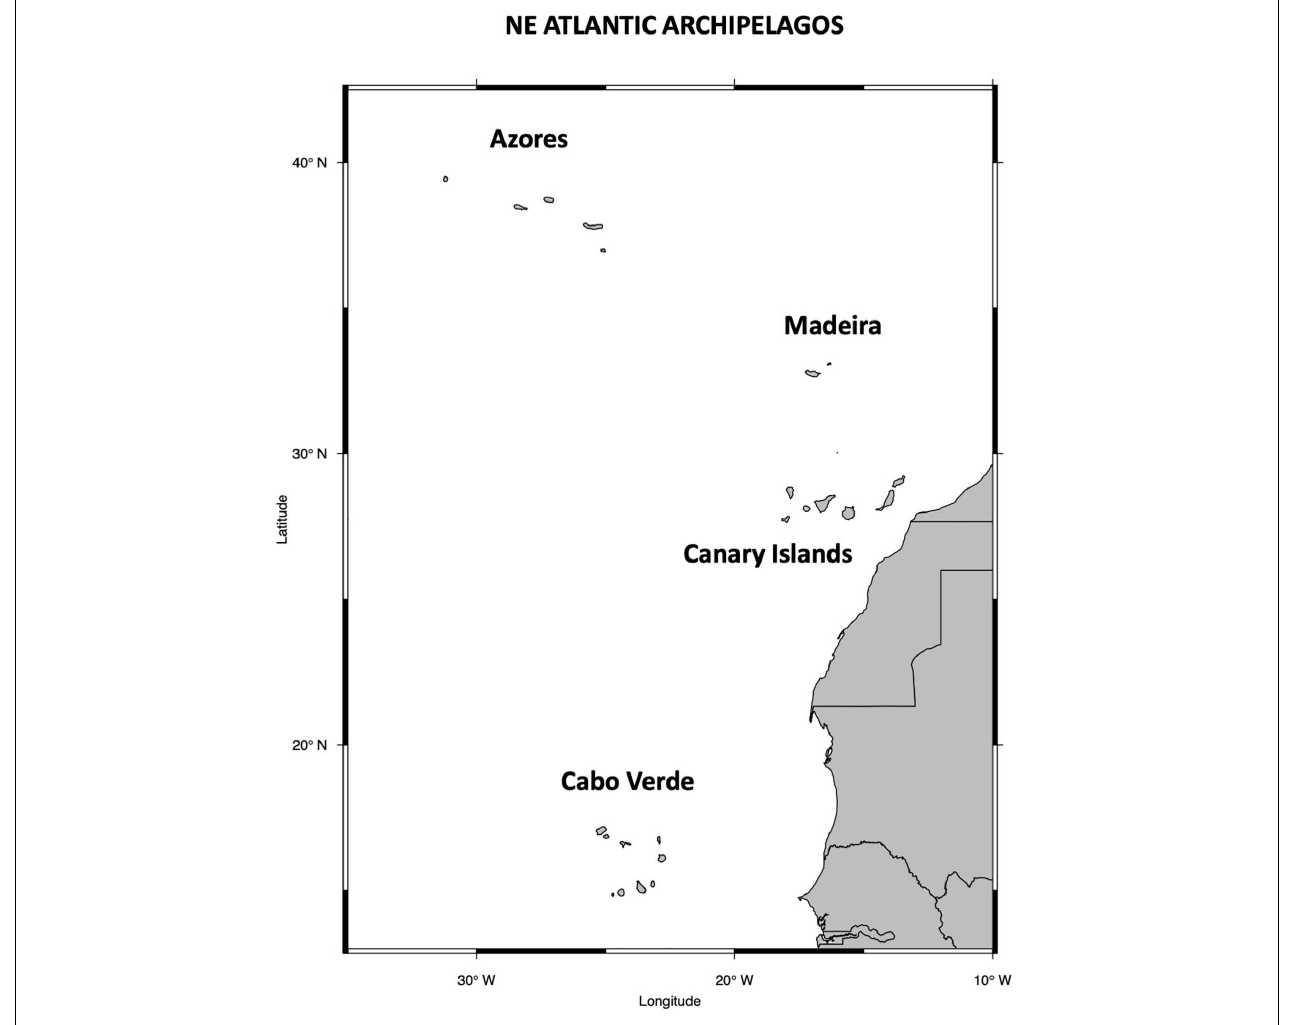
FIGURE 2 | Map of the oceanic archipelagos of Azores, Madeira, Canary Islands and Cabo